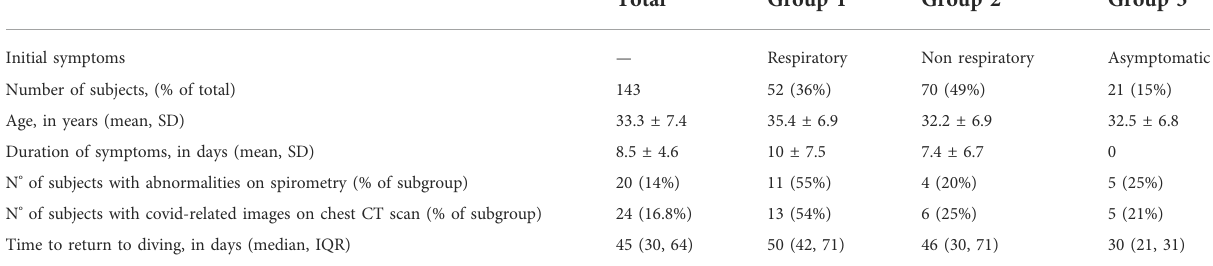
TABLE 1 General characteristics.